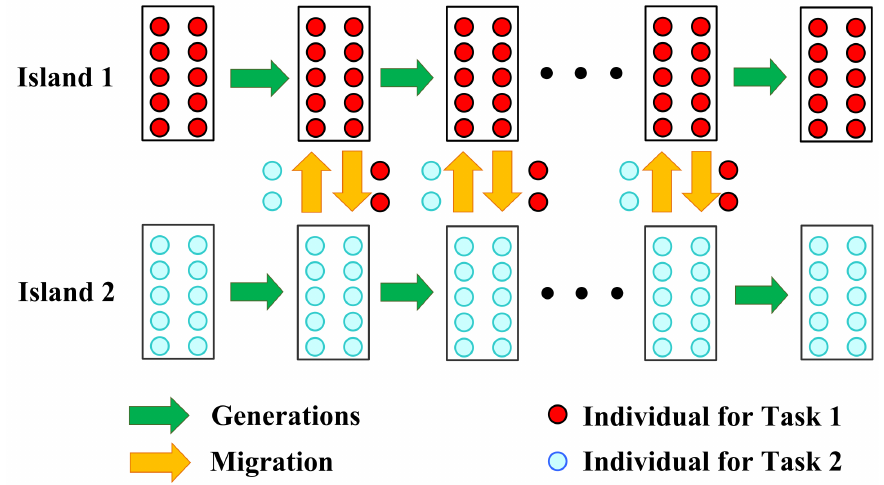
Figure 7. An illustration of the MTEC framework under the standard island model [103].